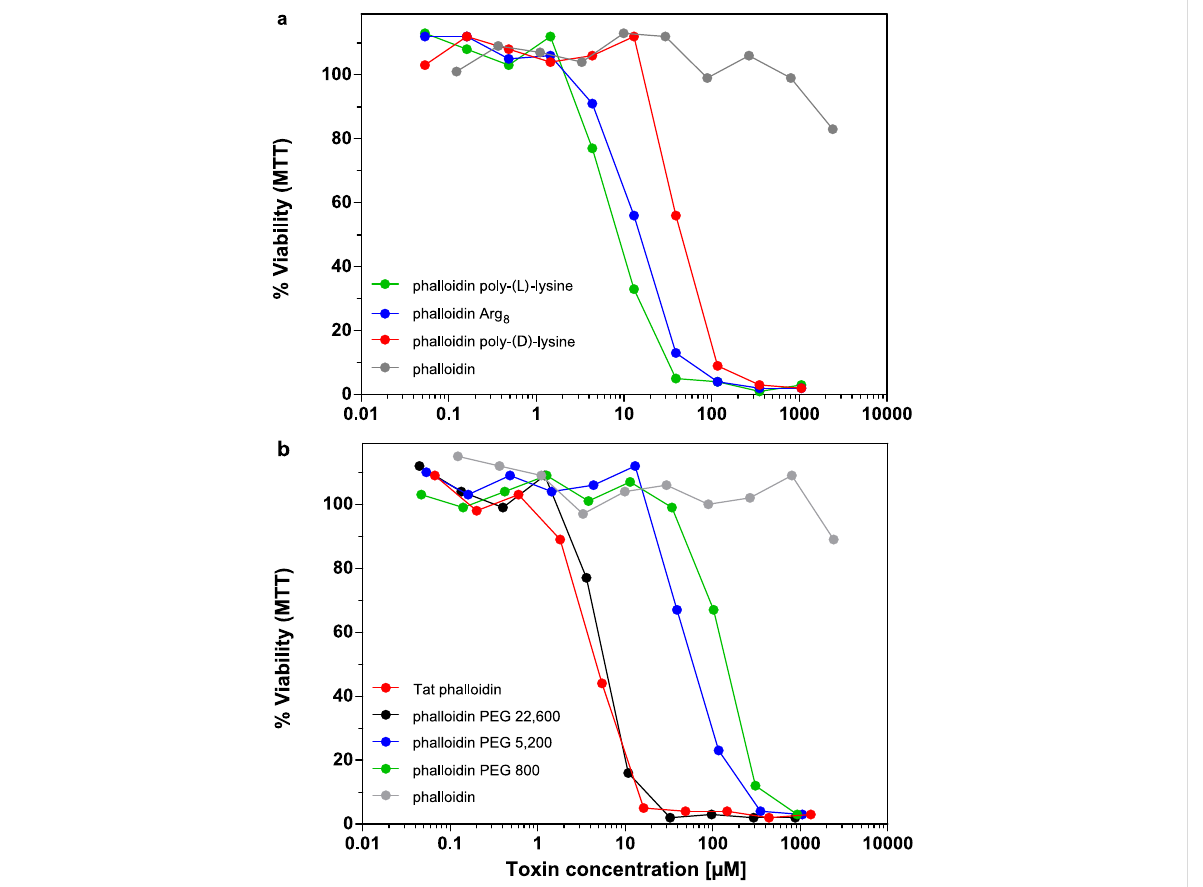
Figure 4: (a) and (b): NIH 3T3 mouse fibroblasts were incubated with various concentrations of phalloidin and phalloidin derivatives. Cell viability was determined after 72 h incubation time by MTT assay.